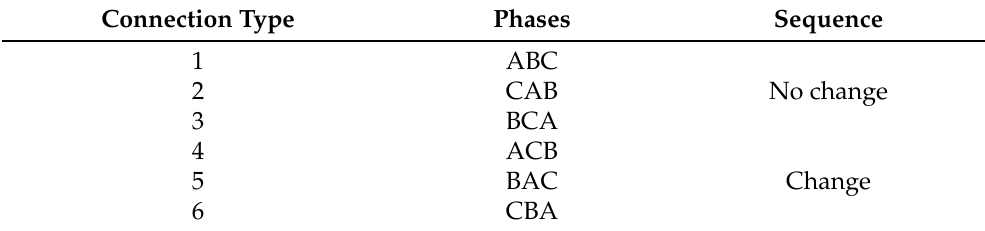
Table 1. Possible connected loads in a three-phase distribution grid